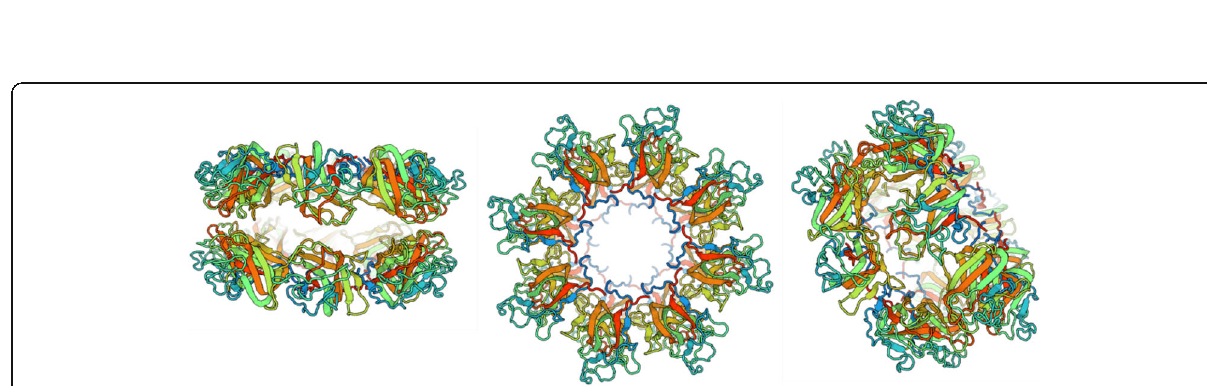
Fig. 6 Different views of the back-to-back octamer rings of wild type RS1 obtained from the Protein Data Bank. (Left) Objective view. (Middle) Plan view. (Right) Perspective